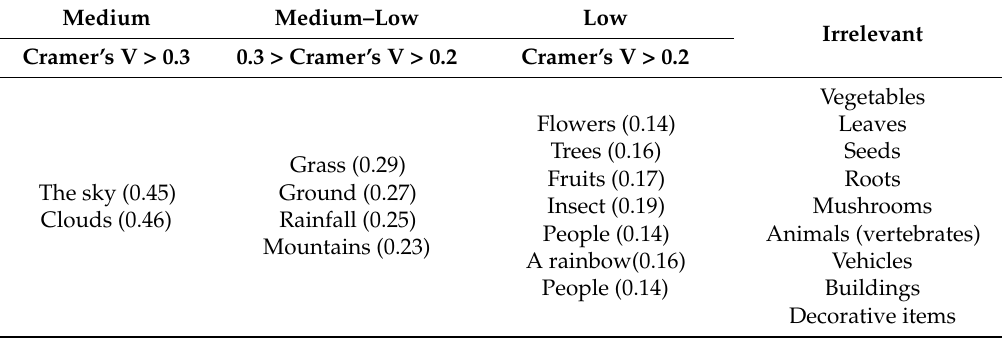
Table 4. The details of the relationship, measured by the Cramer’s V, that the drawing of the sun displays with the other pictorial items identified in the pictures comprising the